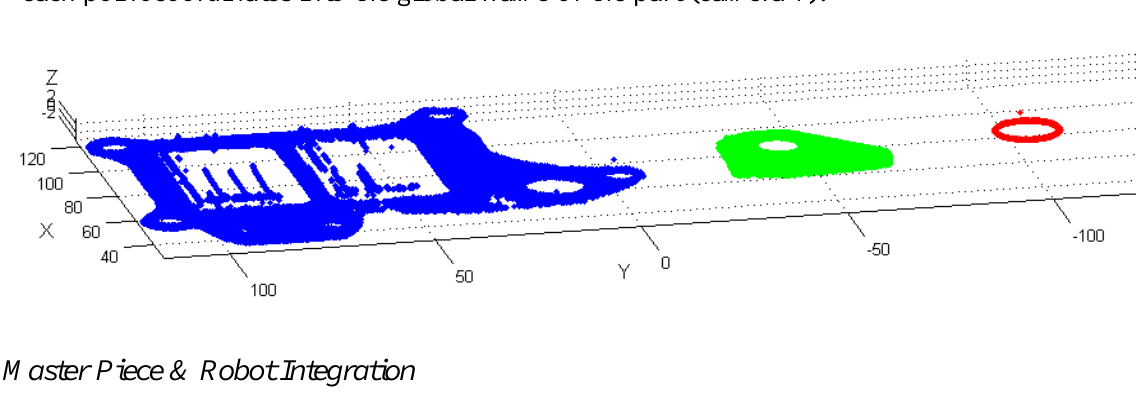
Figure 11. Different part surfaces reconstructed before the frame transformation to express each point coordinates into the global frame of the part (camera